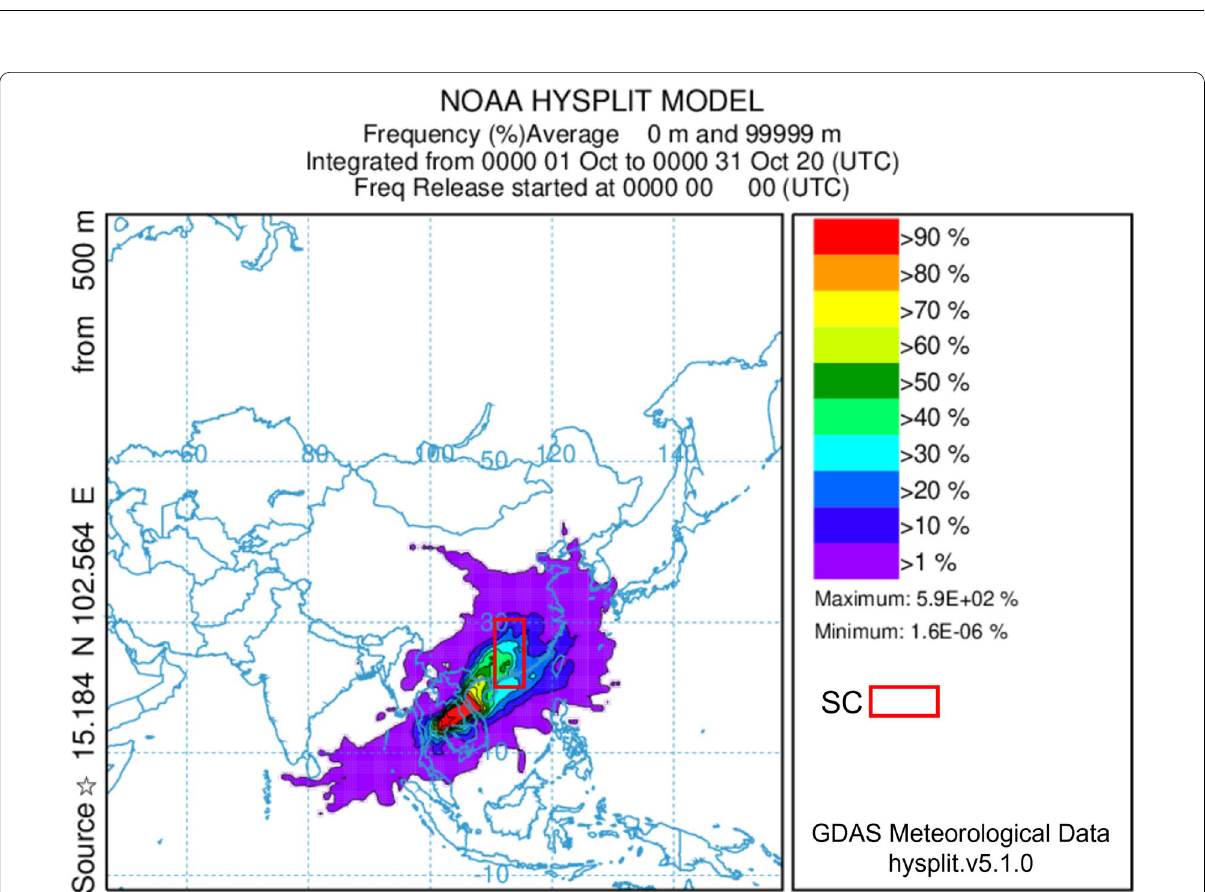
Fig. 5 HYSPLIT frequency plot of five-day backward trajectories in every 6 h at the Phimai site from 500 m in October from 2009 to 2020. Red star: Phimai site. The red box indicates southern